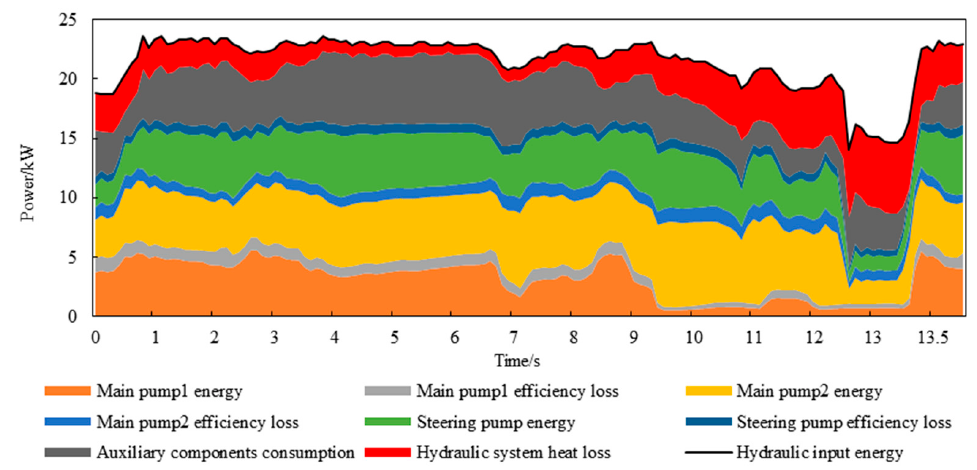
Figure 21. The hydraulic pump energy flow.